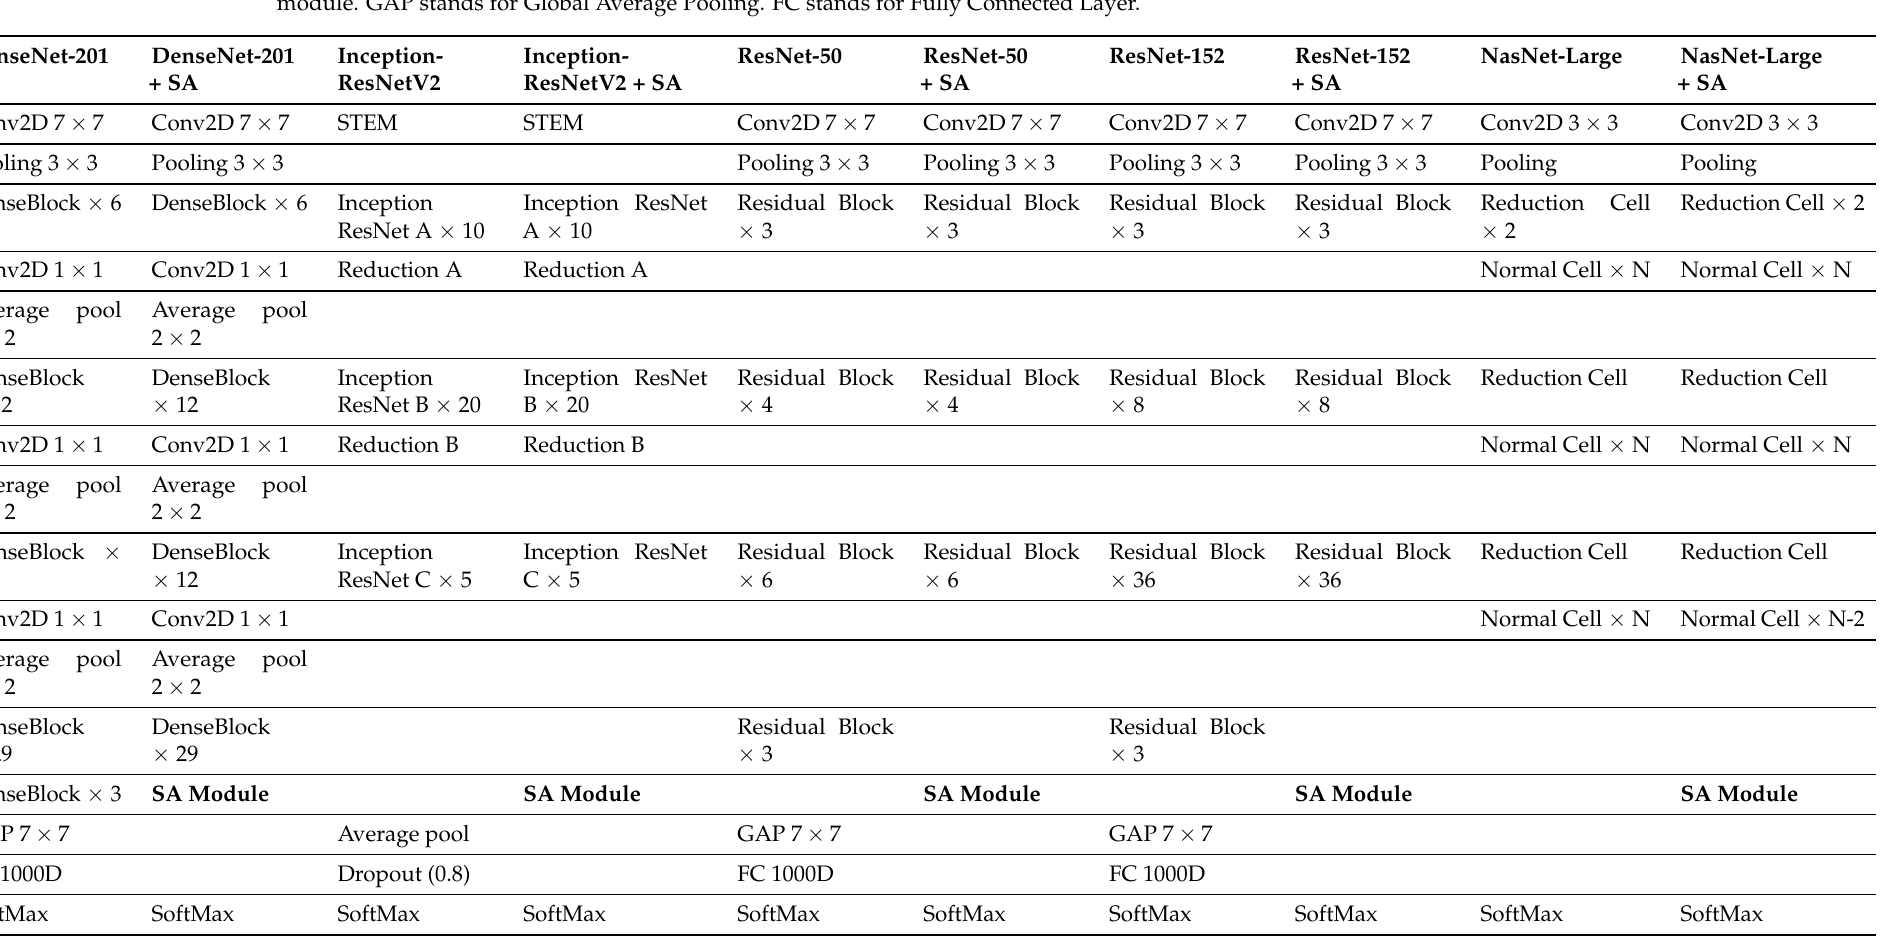
Table A1. Detailed structure of models except for mobile models. SA stands for Soft-Attention, SA Module denotes whether that model uses the Soft-Attention module. GAP stands for Global Average Pooling. FC stands for Fully Connected